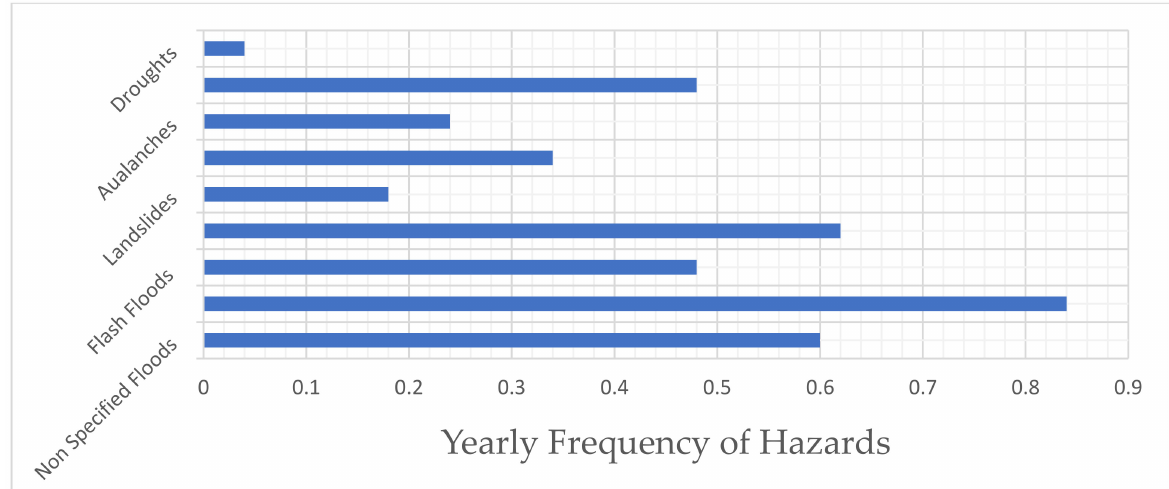
Figure 5. Yearly frequency of hazards, 1970–2020. Source: Authors based on EM-DAT, 2020 (Accessed on 19 May